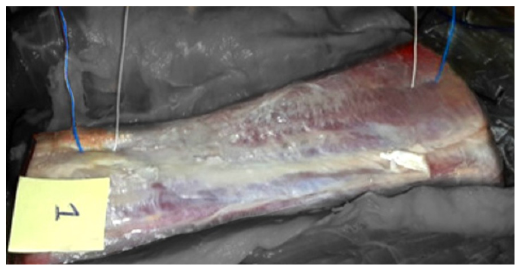
Fig.3: The picture shows the trimmed portion of a right longissimus dorsi muscle from one of the considered animals (285 kg in weight), which was freed from other muscular structures adjacent to it, and was oriented with its rostral head to the upper right. The two external wires are the current injection electrodes and the two internal wires are the electrodes to detect the voltage difference during test number 1 undertaken at the 2 nd day